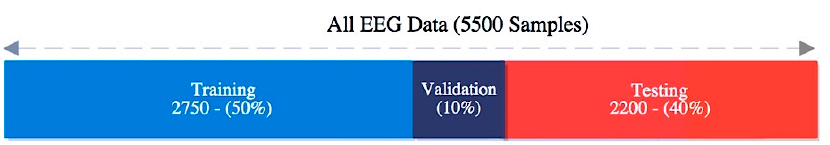
Figure 7. EEG data allocation for training, validation, and testing.